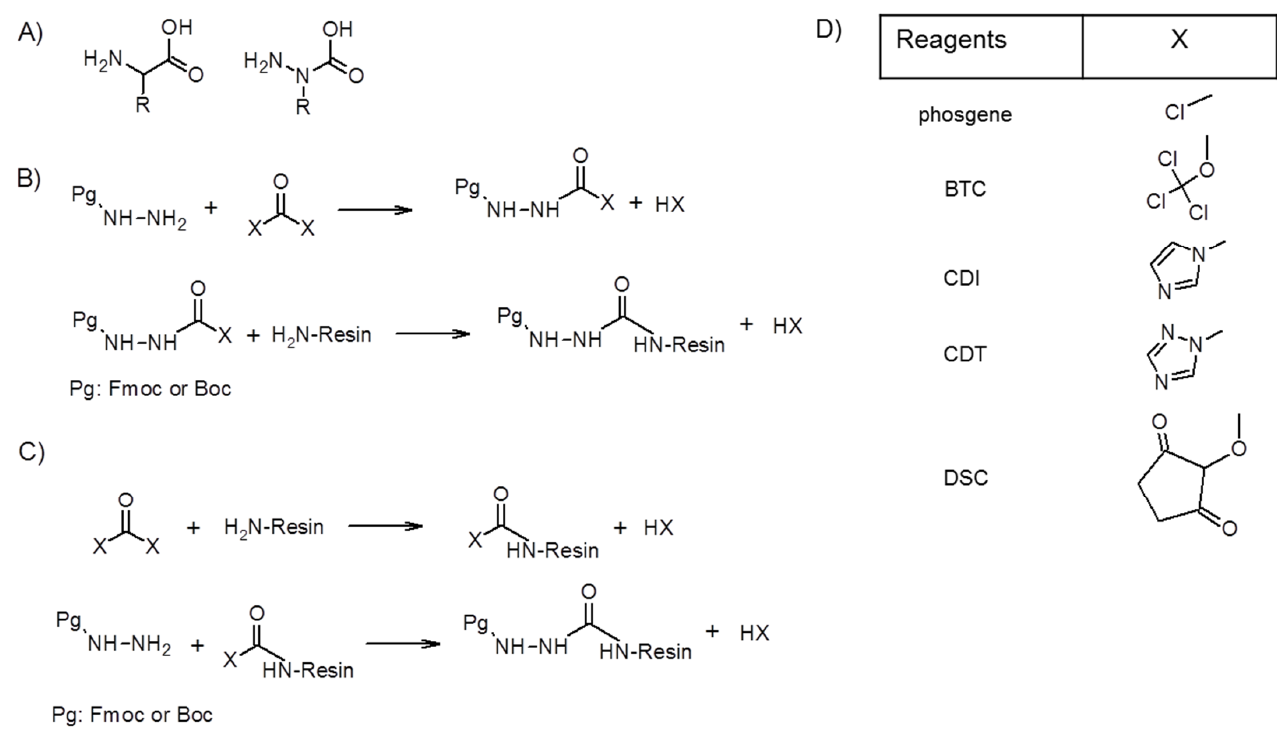
Figure 1. Coupling strategy for azapeptide synthesis. ( A ) The general structure of an amino acid and azaamino acid; ( B ) the protected hydrazide is activated and coupled to the amino group on the resin; ( C ) the amino group on the resin is activated and reacted with the protected hydrazine; ( D ) the reagents can be used for azaamino acid introduction. After coupling, the Fmoc or Boc protecting group can be removed by piperidine and TFA, respectively, and the next amino or azaamino acid can be coupled. BCT: bis -(trichloromethyl)carbonate; CDI: carbonyldiimidazole; CDT: 1,1′-Carbonyl-di-(1,2,4-triazole); DSC: using N , N ’-disuccinimidyl carbonate.